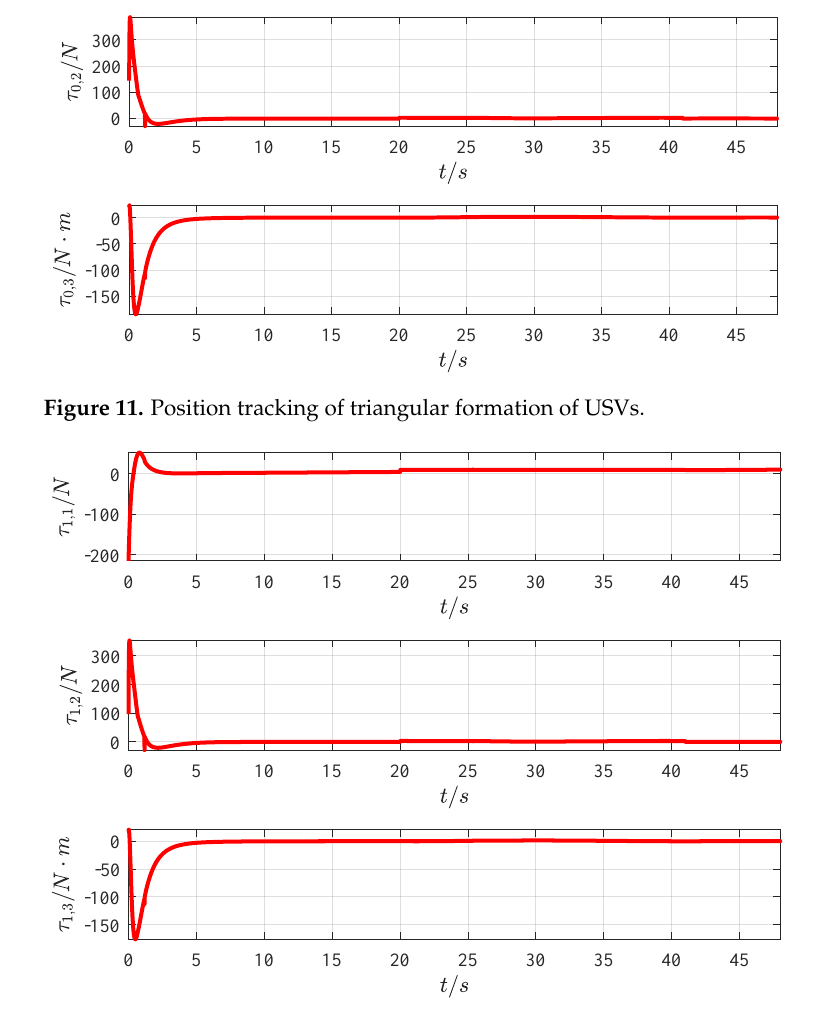
Figure 12. Velocity tracking of triangular formation of